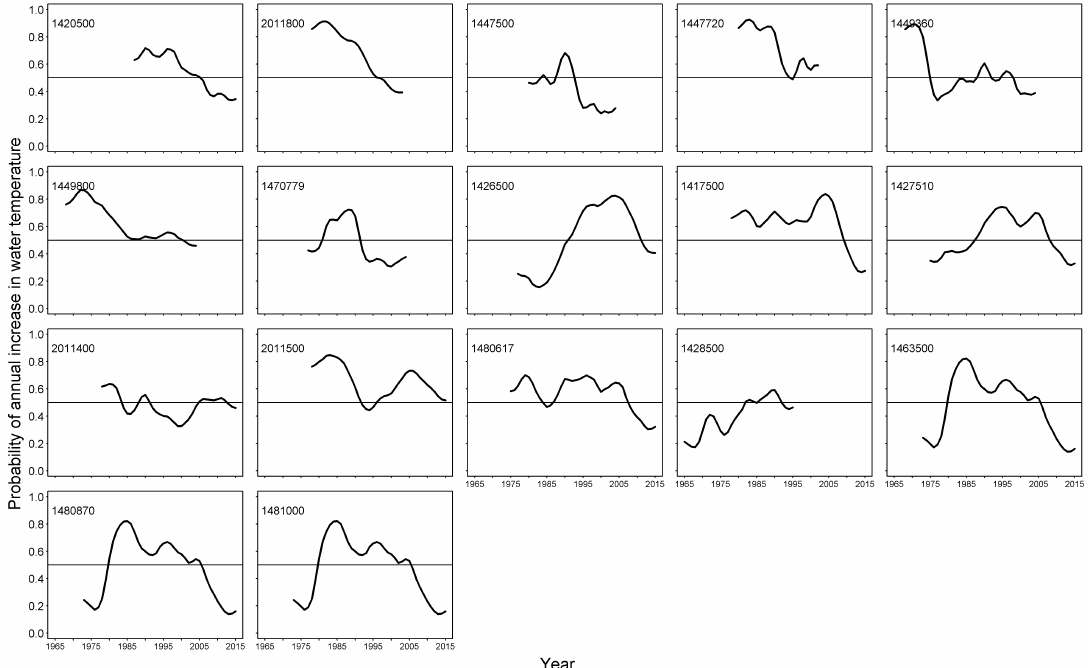
Figure 4. Annual probabilities of an increase in winter river water temperature for sites located in the eastern U.S. (see Figure 1 for site map). Numerical codes on each panel correspond to the U.S. Geological Survey gauge